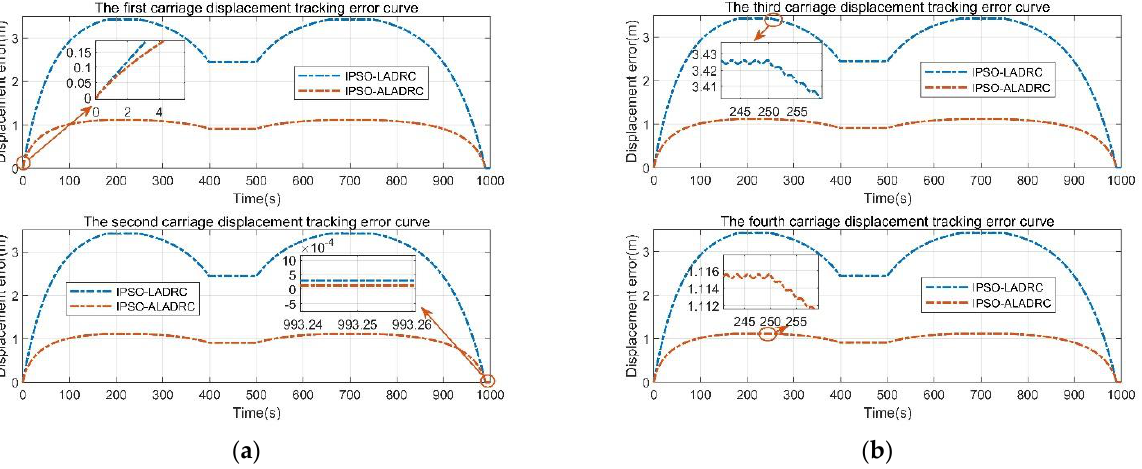
Figure 14. Displacement tracking error of the four carriages: ( a ) Displacement tracking error of the first two carriages; ( b ) Displacement tracking error of the last two carriages.